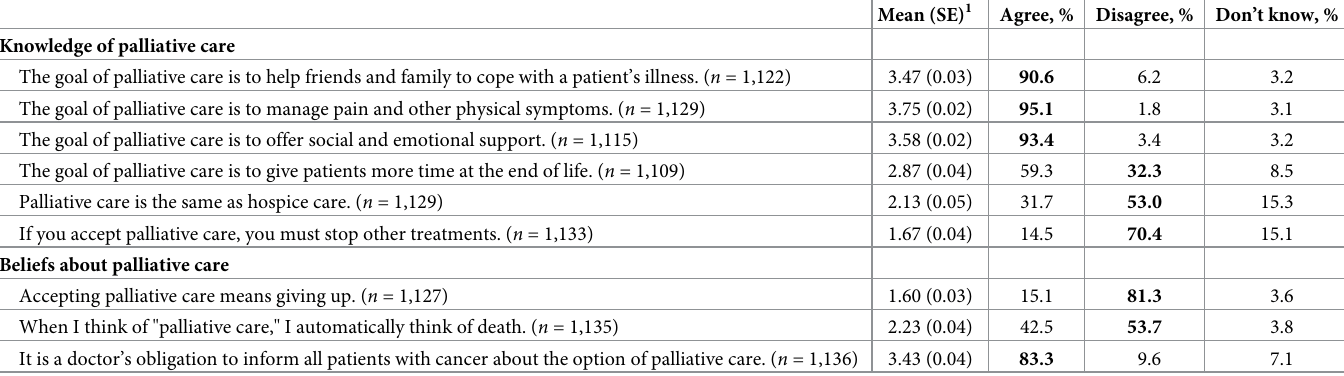
Table 1. Knowledge and beliefs about palliative care means, standard errors, and frequencies of specific